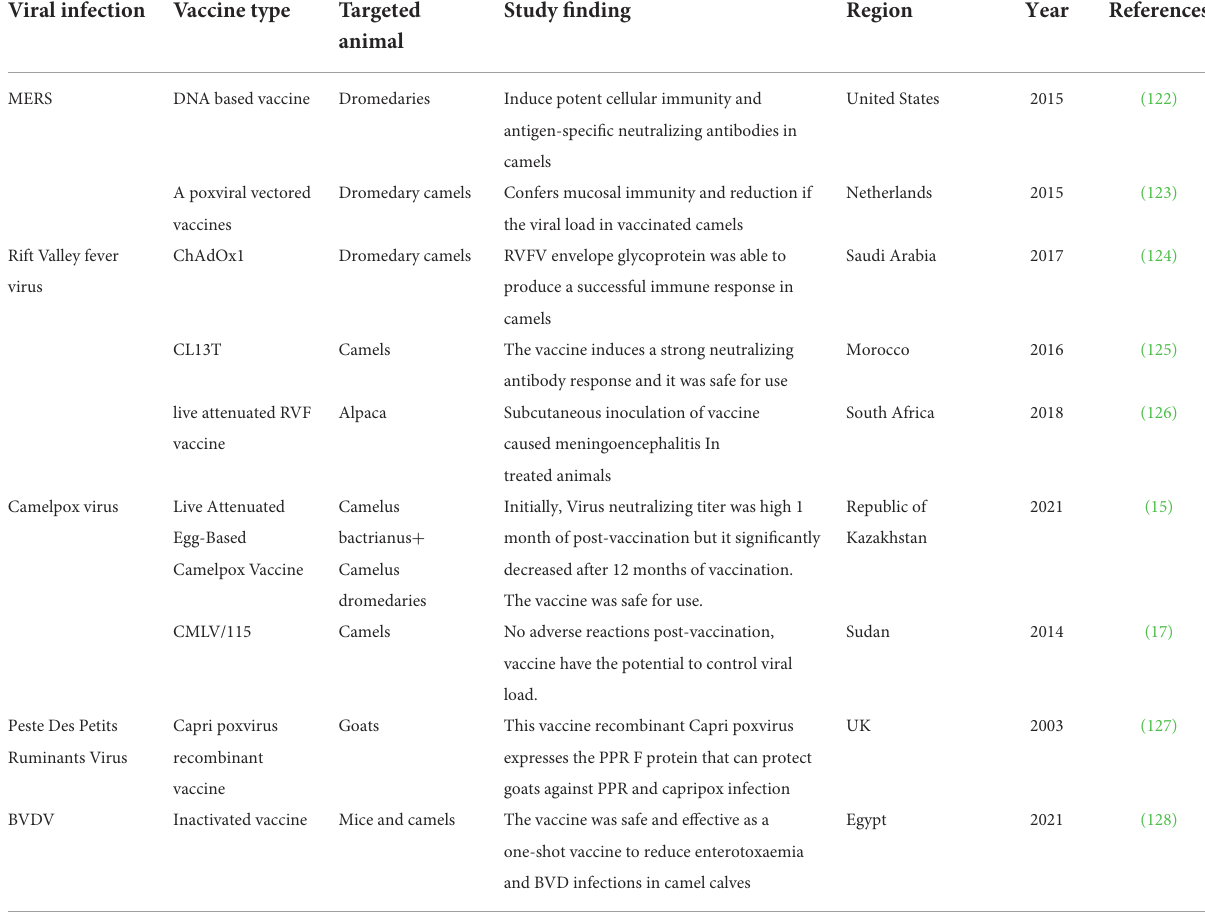
TABLE 2 Vaccine trials conducted on camels for different viral